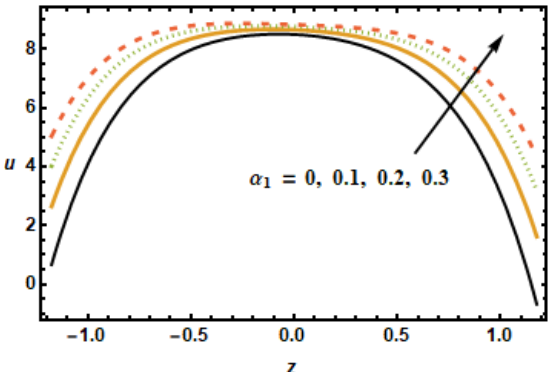
Figure 5. Effects of first order slip α 1 on u .